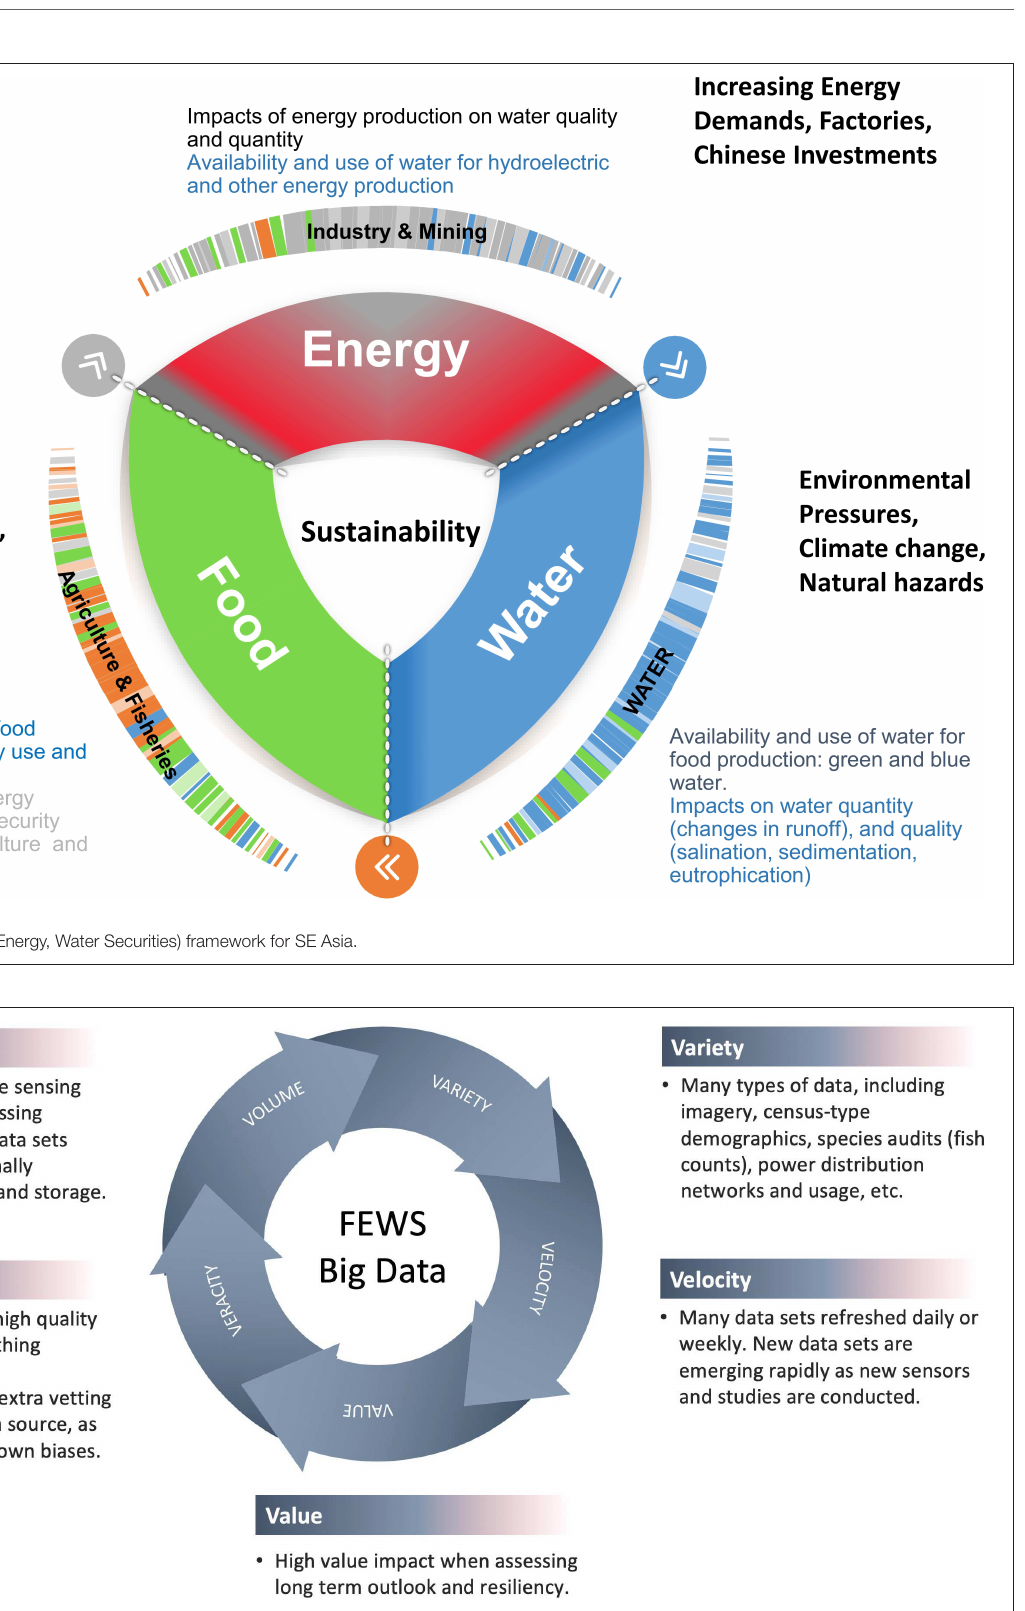
FIGURE 2 | “Big data” is characterized by the 5V’s-Velocity, Volume, Value, Variety, and Veracity.